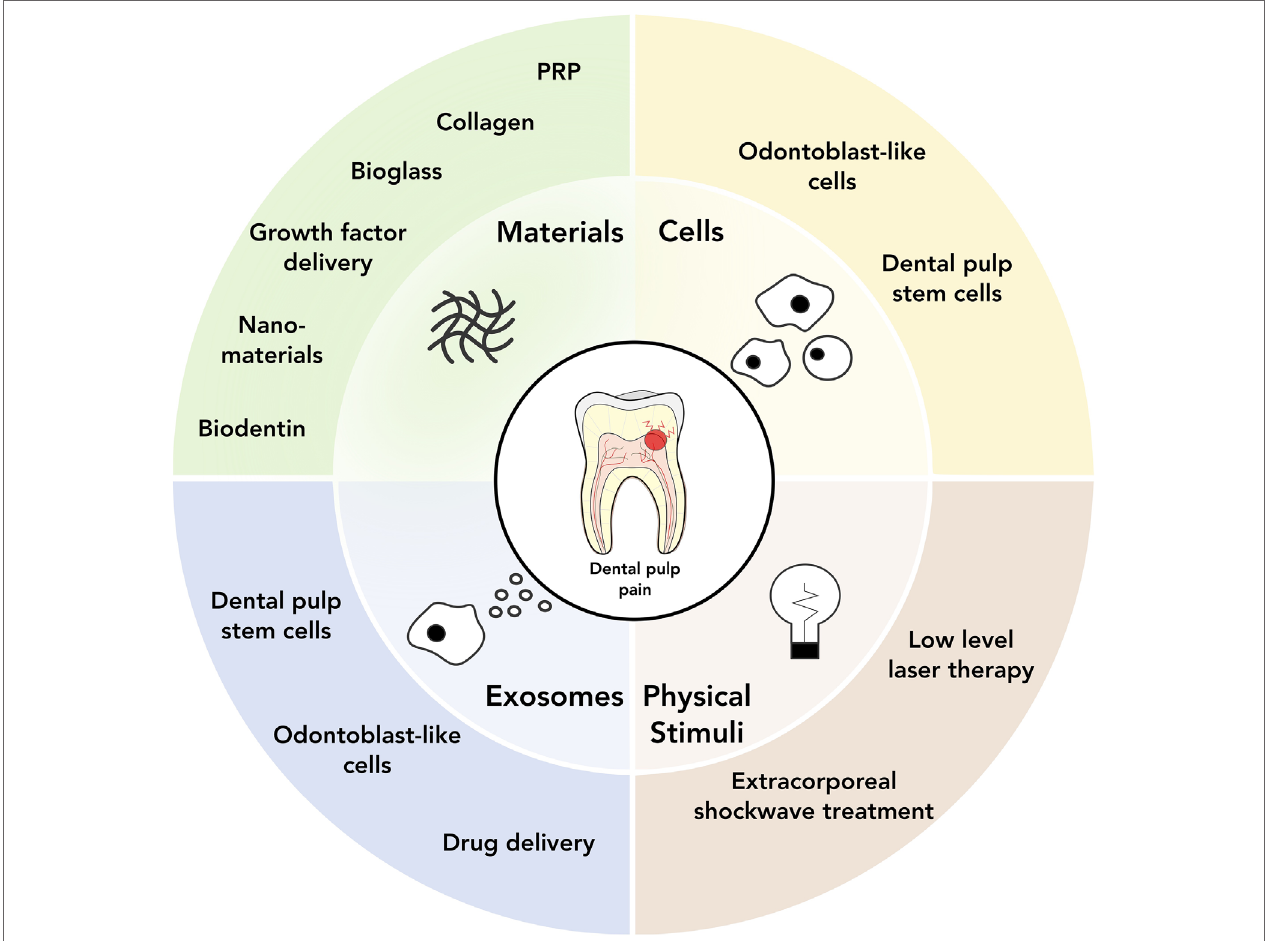
FIGURE 2 | Overview of current and potential regenerative medicine approaches for dental pain